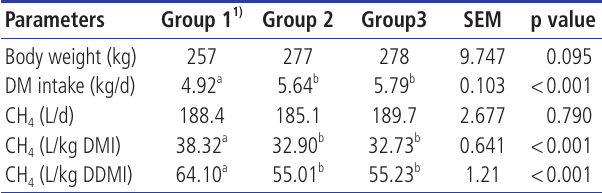
Table 5. Effect of feeding blend of essential oils (BEO) on methane emission in growing buffalo calves